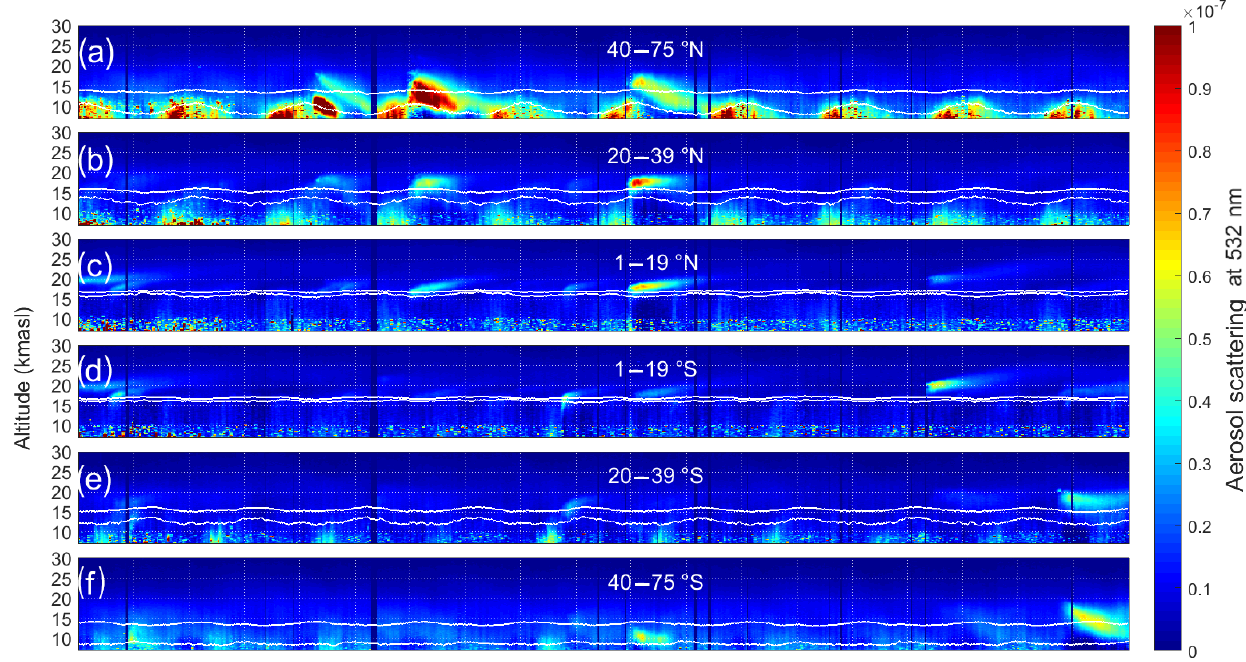
Figure 5. Aerosol scattering against time and altitude in six latitude bands, each covering 16% of the Earth’s surface area. The white lines mark the mean altitudes of the tropopause and the 380K isentrope.